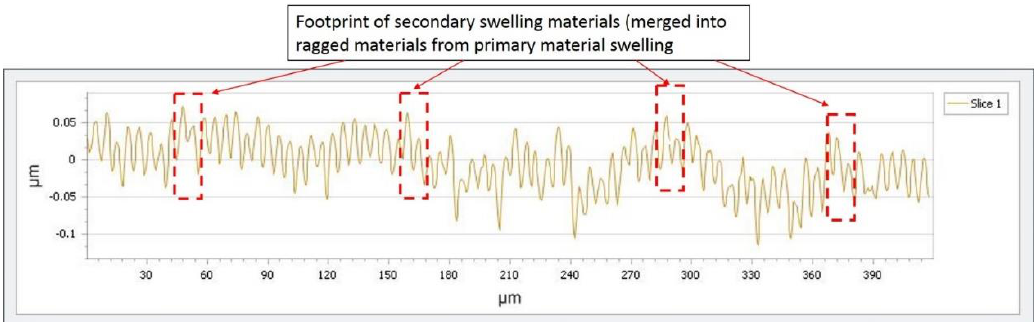
Figure 7. The surface profile of machined surface.